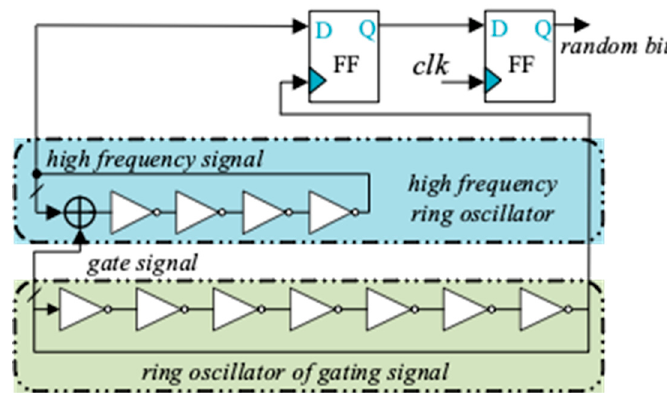
Figure 12. Circuit diagram of 1-bit random generator.